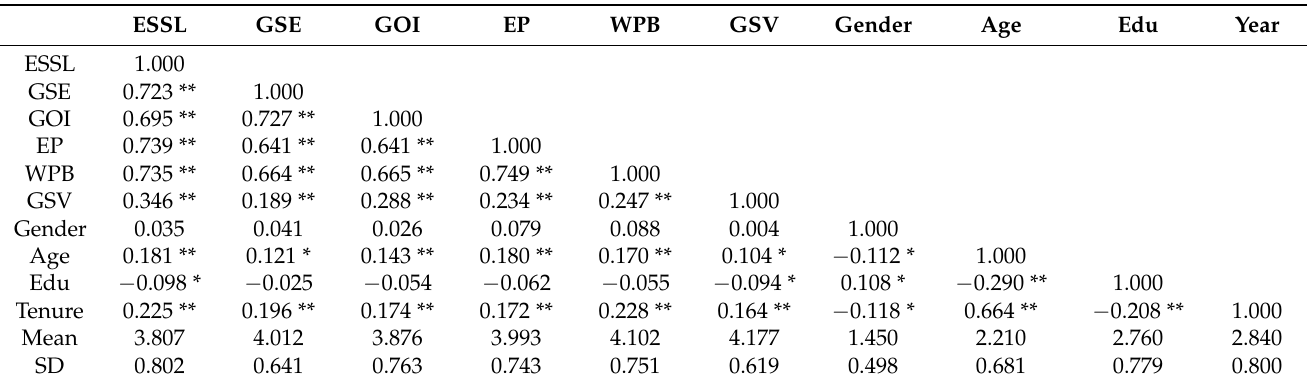
Table 3. Mean, standard deviation, and correlation.